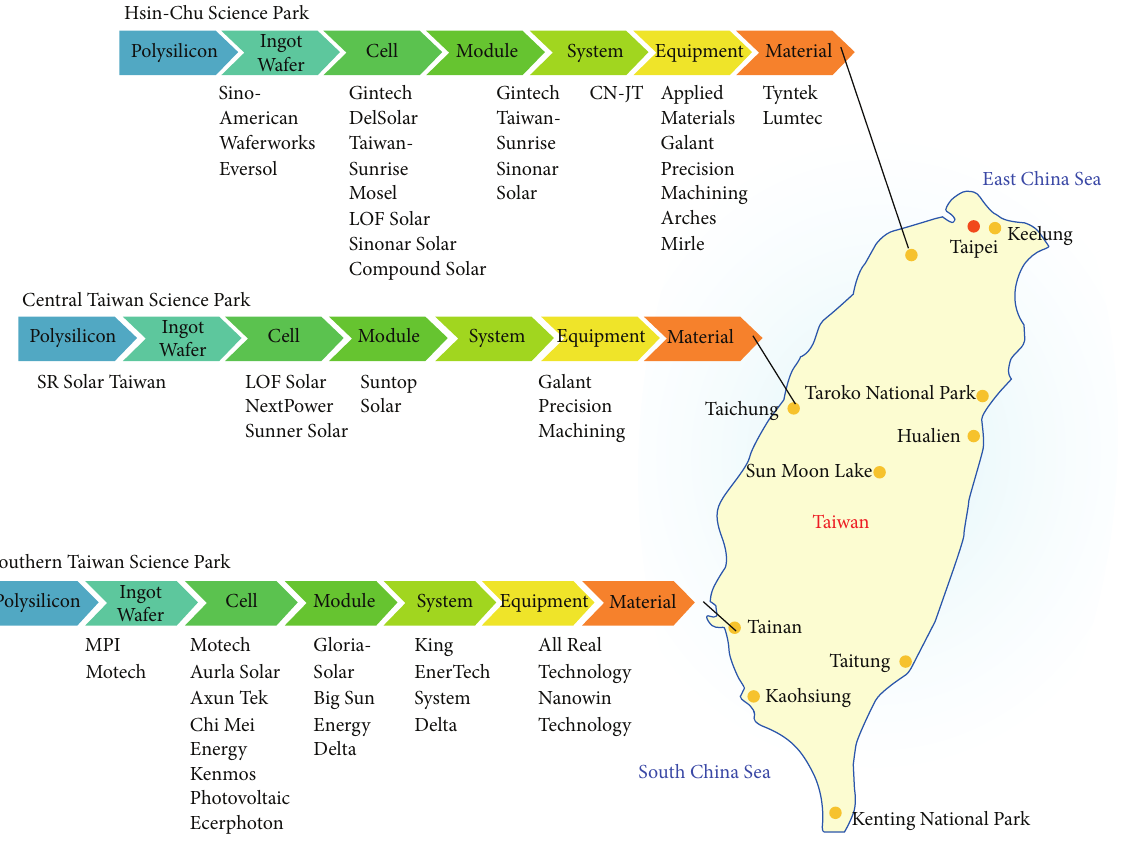
Figure 8: Solar photovoltaic firms in Taiwan Science Parks. Source: this